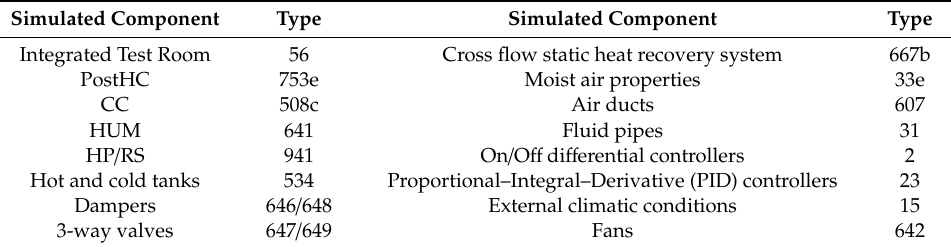
Table 7. TRaNsient SYStems (TRNSYS) Types used in the simulation model.